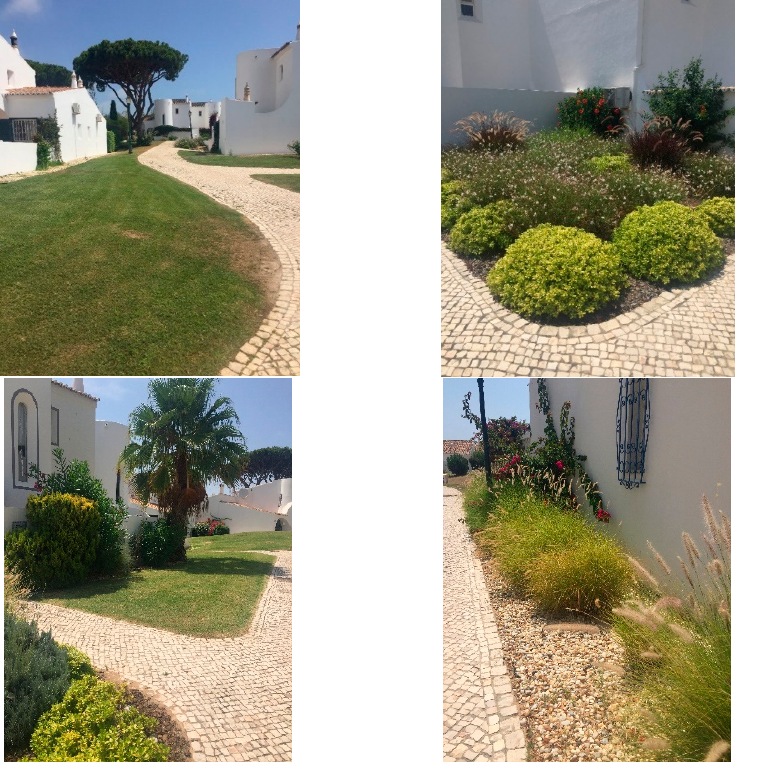
Figure 3. Case study 1: landscape and system boundaries.